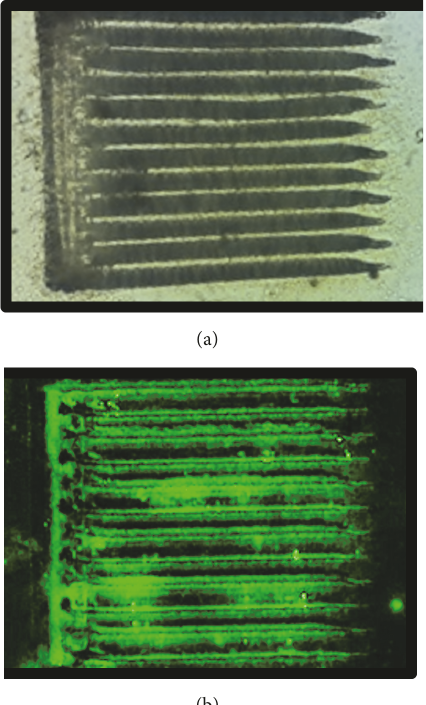
Figure 7: PVA film doped with nanoparticles made of the poly(3- HT- co -EDOT) copolymer. Images of the film obtained with (a) standard optical microscopy and (b) fluorescence microscopy with infrared excitation at 750 nm. The micropattern on the PVA film consists of lines of 150 𝜇 m in length separated by 50 𝜇